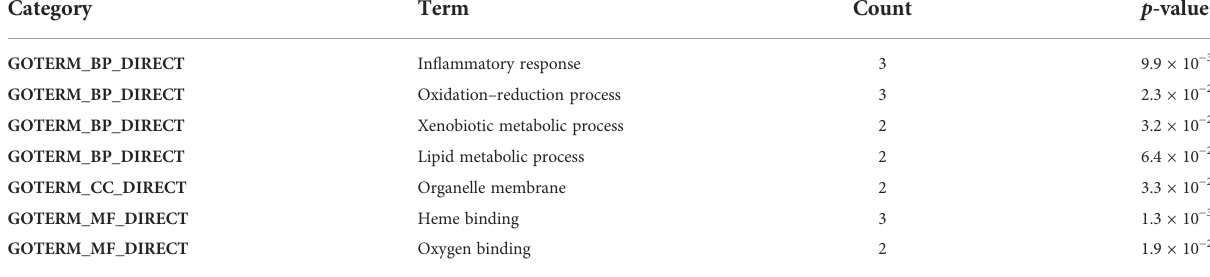
TABLE 3 Gene ontology of type 2 diabetes mellitus-associated DEGs.